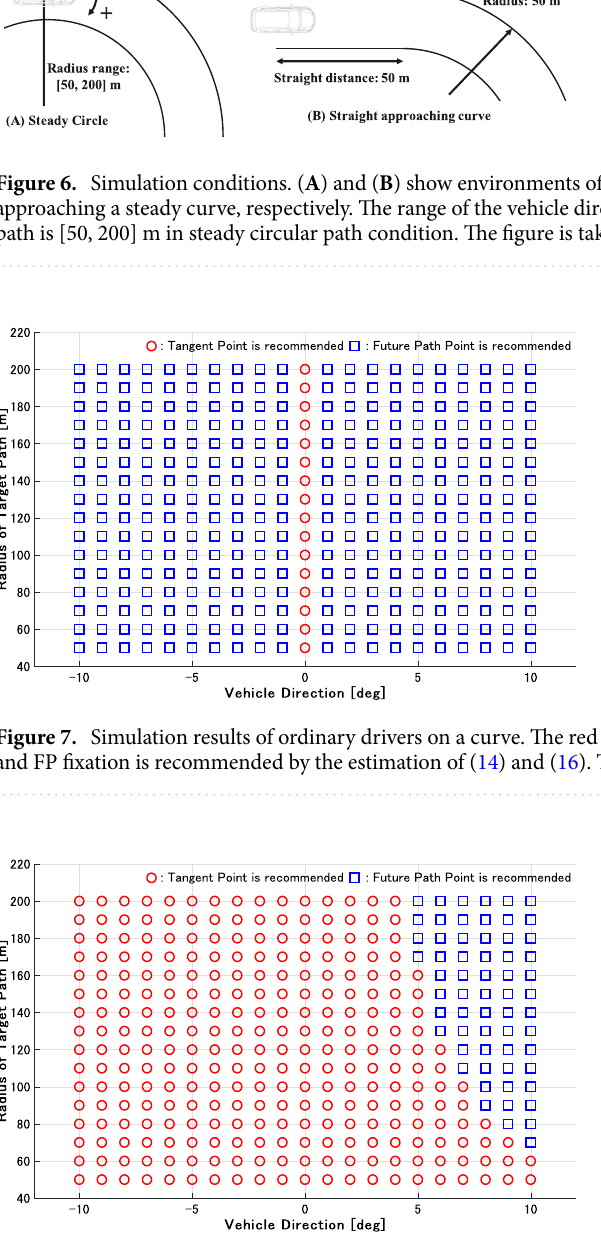
Figure 8. Simulation results of novice drivers on a curve. The red circle and blue square denote that the TP and FP fixation is recommended by the estimation of (15) and (16). The figure is taken from 29